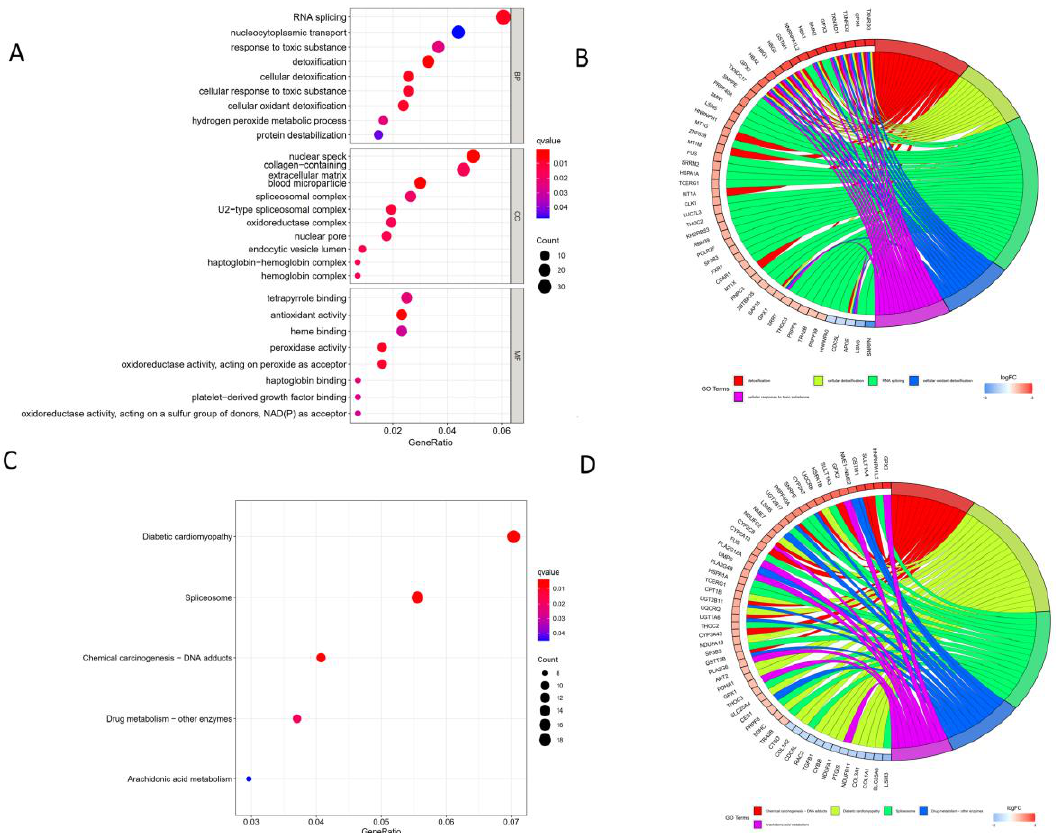
Figure 2. Functional and pathway analysis through GO and KEGG. ( A ) MF, BP, and CC in GO categories of DEGs. ( B ) Circos plot indicating the relationship between genes and GO terms. ( C ) KEGG analysis of DEGs. ( D ) Circos plot indicating the relationship between KEGG